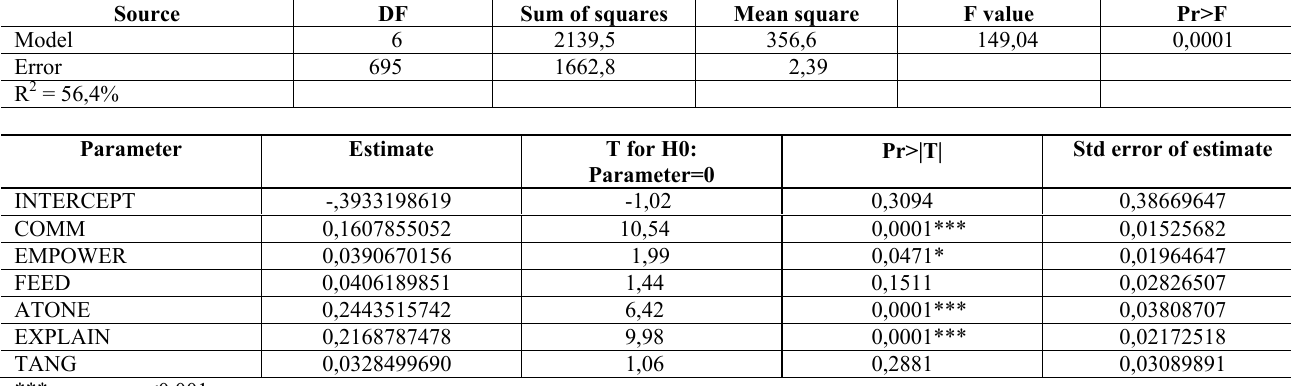
Table 7: Multiple regression results: Satisfaction